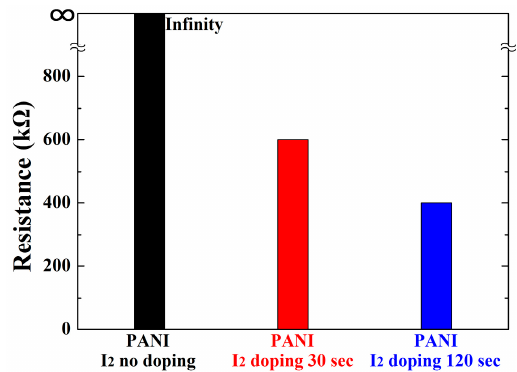
Figure 10. Changes in resistance of PANI films grown on substrates of interdigitated electrodes when using advanced APPJs device after 60 min deposition with no I 2 doping, with 30 s I 2 doping, and with 120 s I 2 doping following deposition.